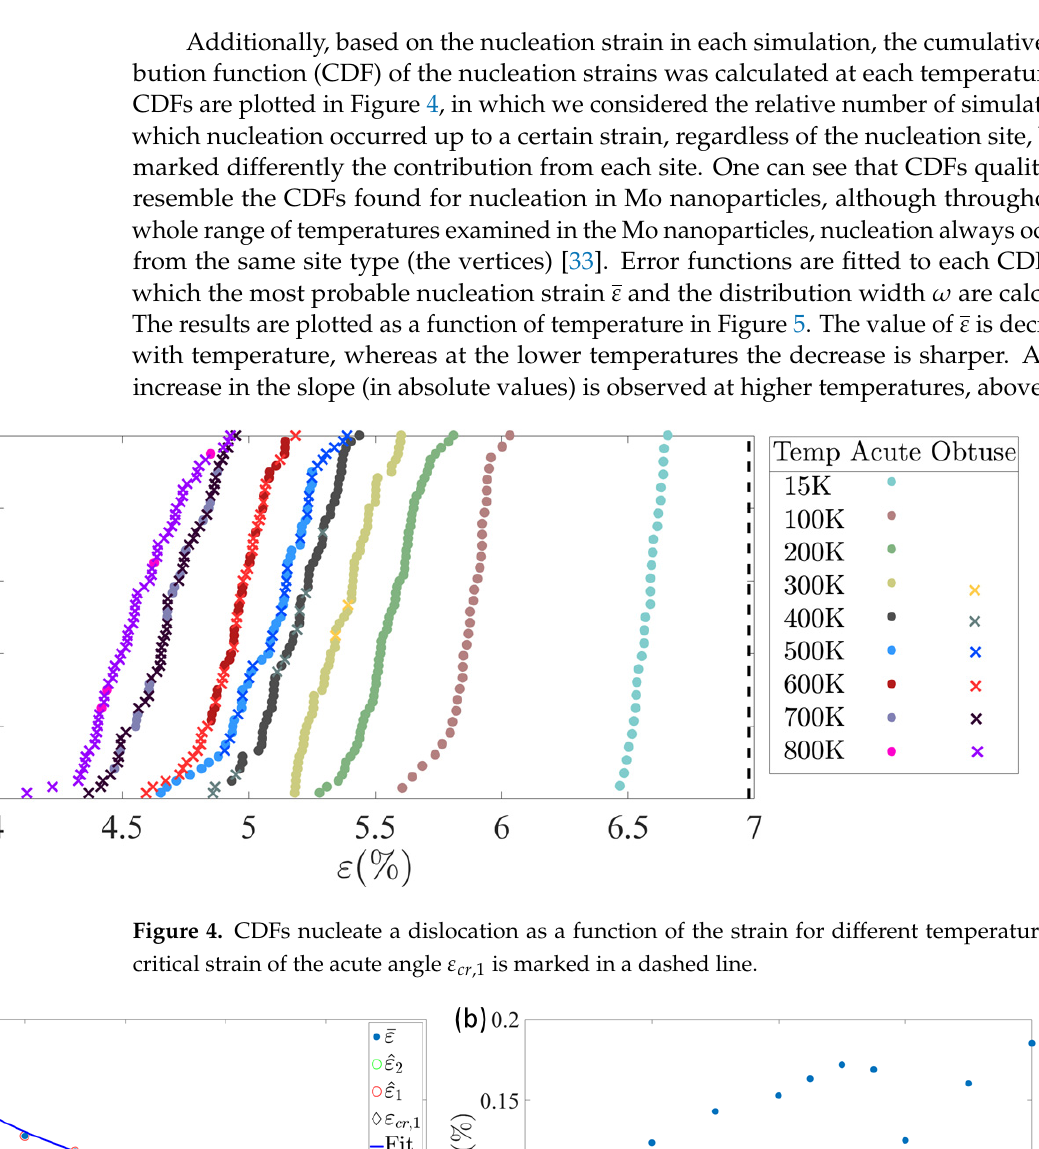
Figure 3. The probability to nucleate a dislocation at the acute angle is based on the MD simulations. A phenomenological function was fitted to the results.